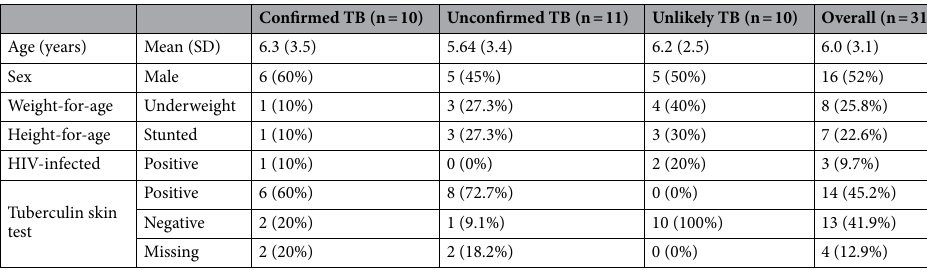
Table 1. Demographic and clinical characteristics across the TB study